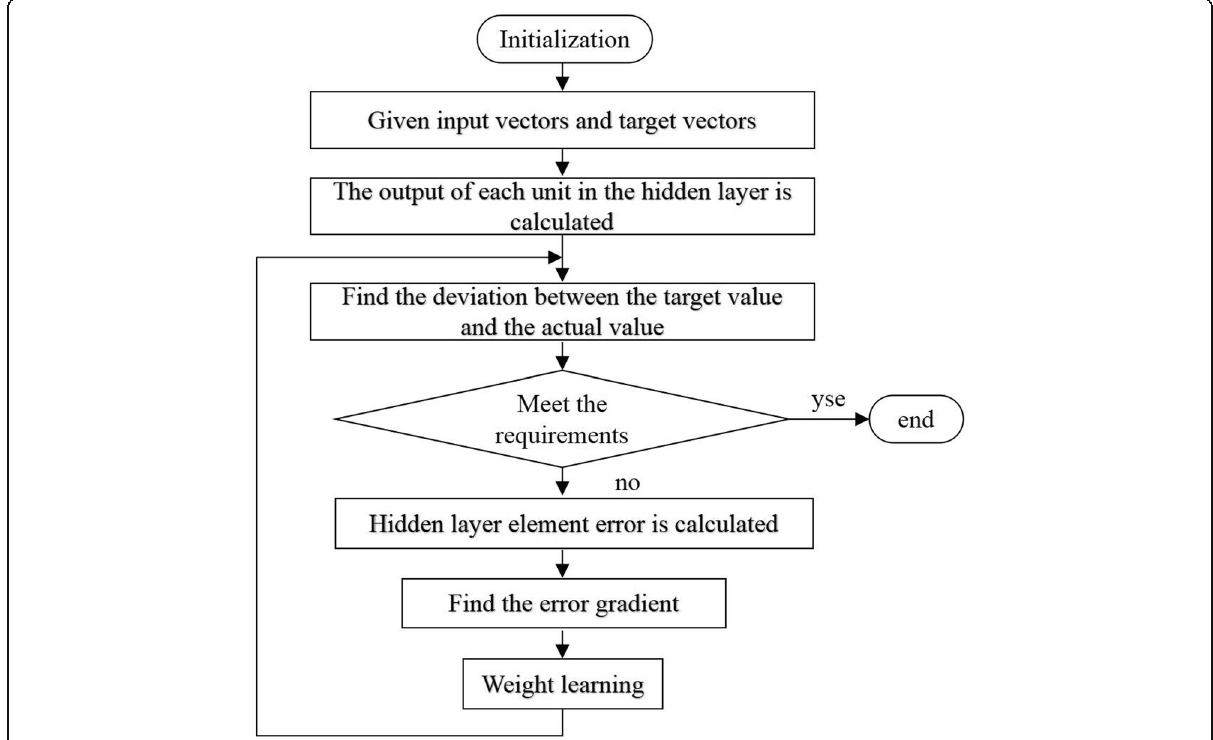
Fig. 2 BP neural network learning algorithm flow